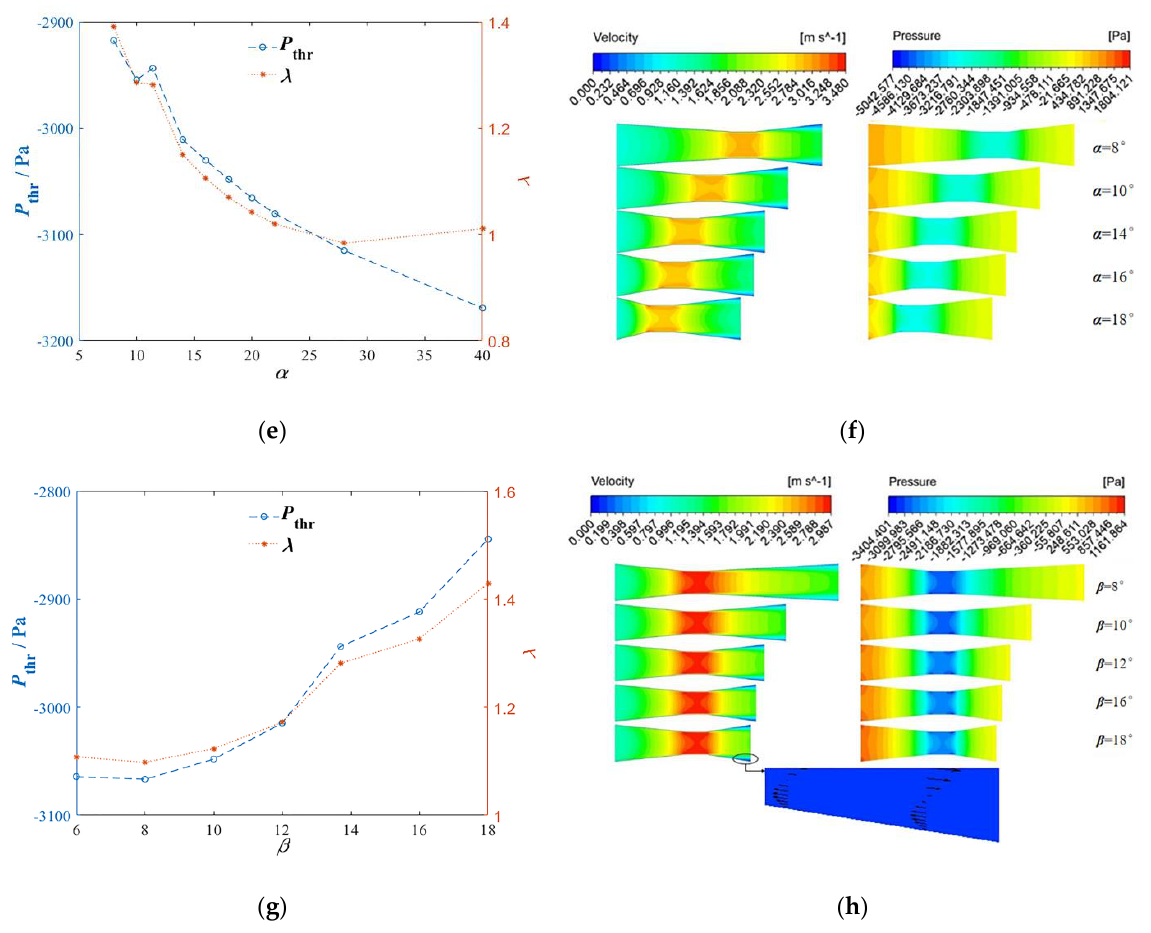
Figure 8. The effects of ( a , b ) γ 1 , ( c , d ) δ , ( e , f ) α , ( g , h ) β on P thr , λ and the velocity and pressure distributions in VT.